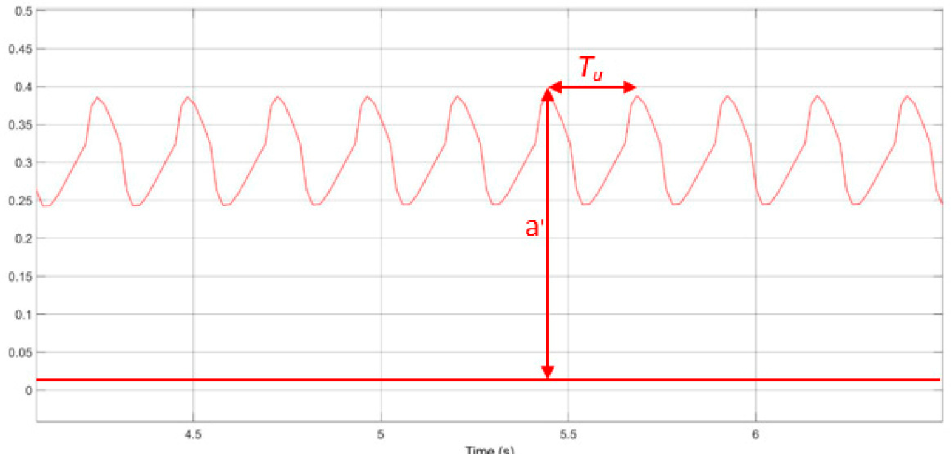
Figure 6. Step response of ECS output flow signal with relay feedback method.